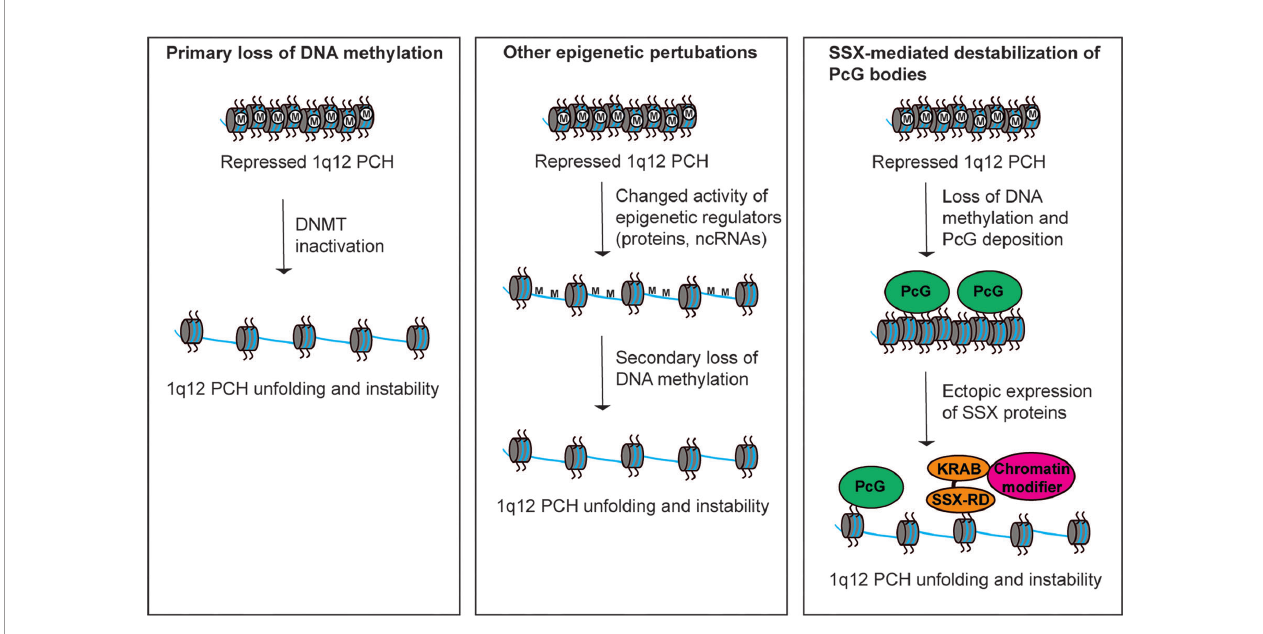
FIGURE 2 | Different models for perturbation of 1q12 pericentromeric heterochromatin stability. (Left) Hypomethylation of satellite DNA in cancer cells leads to loss of epigenetic repression and subsequent unfolding and destabilization of 1q12 PCH. This may be caused by inactivation of DNA methyltransferases. (Middle) Deregulation of epigenetic mechanisms (other than DNA methylation) controlling the repression of 1q12 PCH may lead to unfolding and destabilization of 1q12 PCH associated with a secondary loss of DNA methylation. (Right) 1q12 pericentromeric DNA is epigenetically reprogrammed into PcG domains in response to loss of DNA methylation. These domains (i.e., PcG bodies) may be targeted by SSX proteins ectopically expressed in cancer cells leading to 1q12 PCH unfolding and